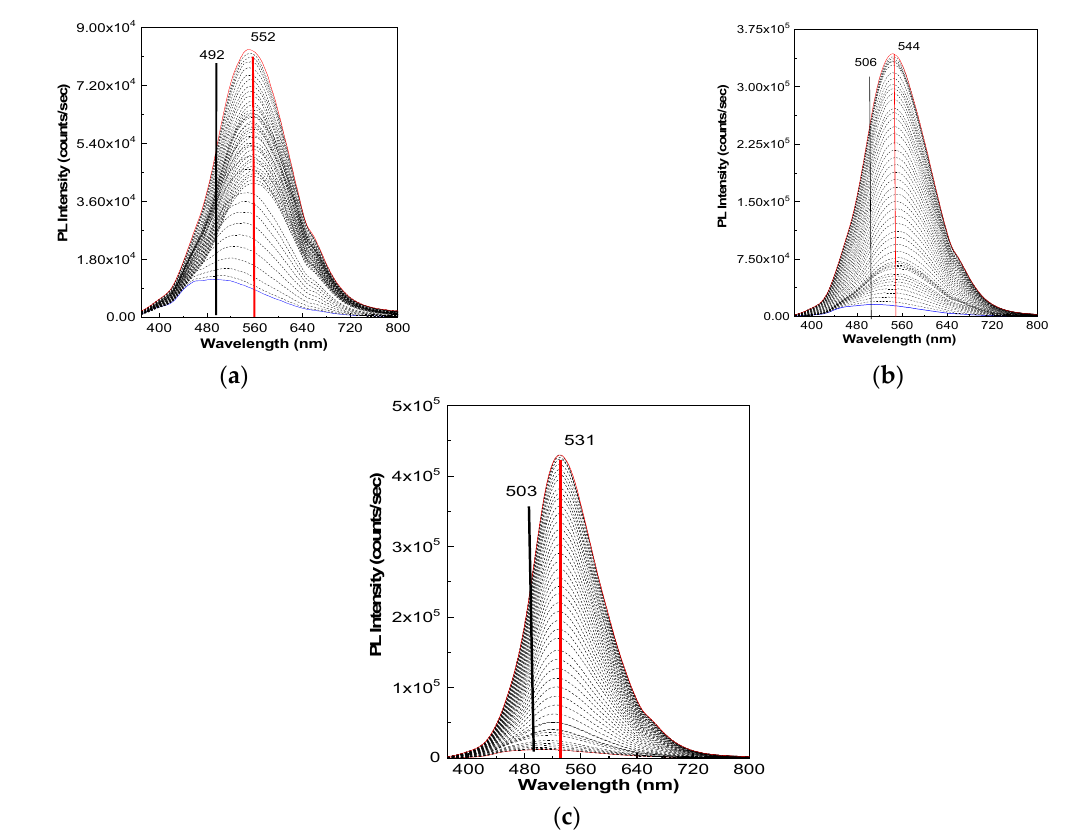
Figure 3. PL spectra of the AZA:ST samples with ST concentrations in the reaction mixture of 25 wt.% ( a ), 50 wt.% ( b ) and 75 wt.% ( c ), recorded at λ exc = 300 nm. Blue and red curves indicate the PL spectra of samples in dark conditions and after an UV exposure time of 600 min. Black curves correspond to PL spectra collected after every 130 s of UV irradiation.